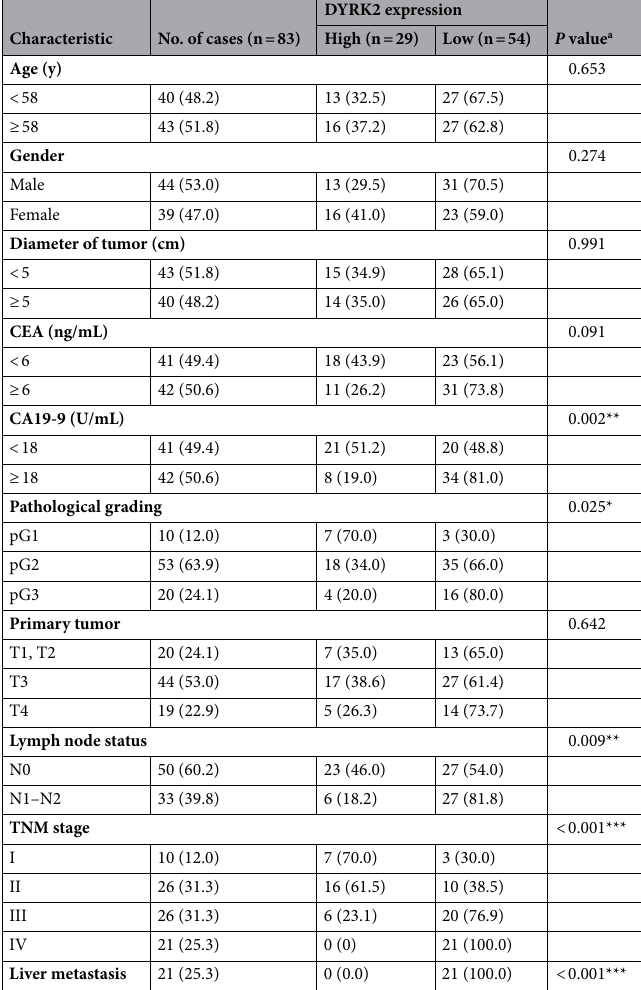
Table 1. Correlation between DYRK2 expression and clinicopathologic characteristics in patients with CRC. a χ 2 test. * P < .05. ** P < .01. *** P <